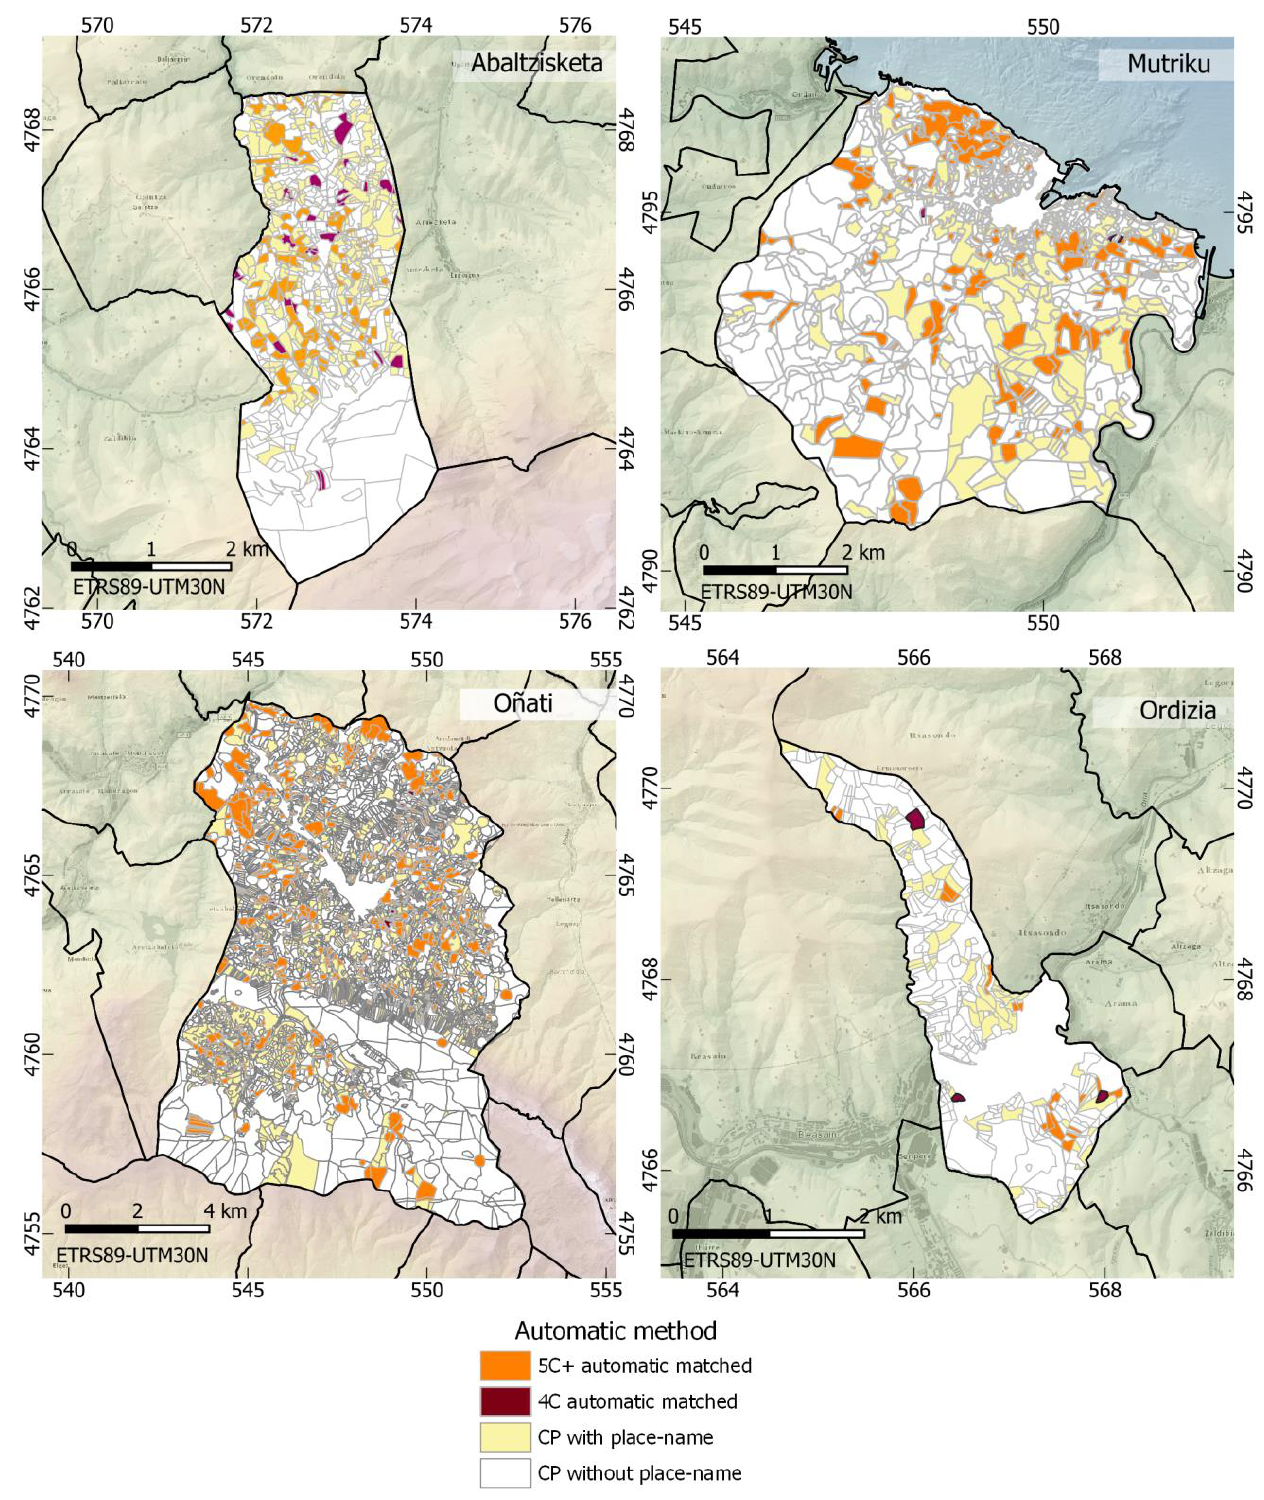
Figure 7. Cadastral parcels selected automatically (4C and 5C+ matching). Frame coordinates in